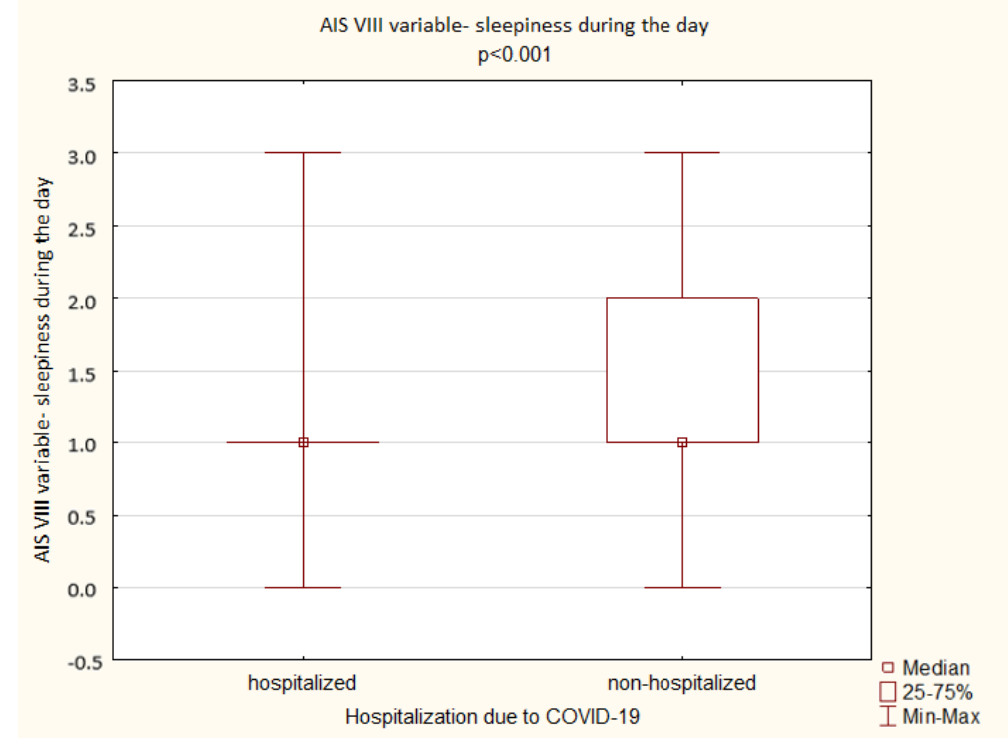
Figure 9. Hospitalized vs. non-hospitalized patients’ results in the AIS VIII variable—sleepiness during the day (Mann–Whitney U test).